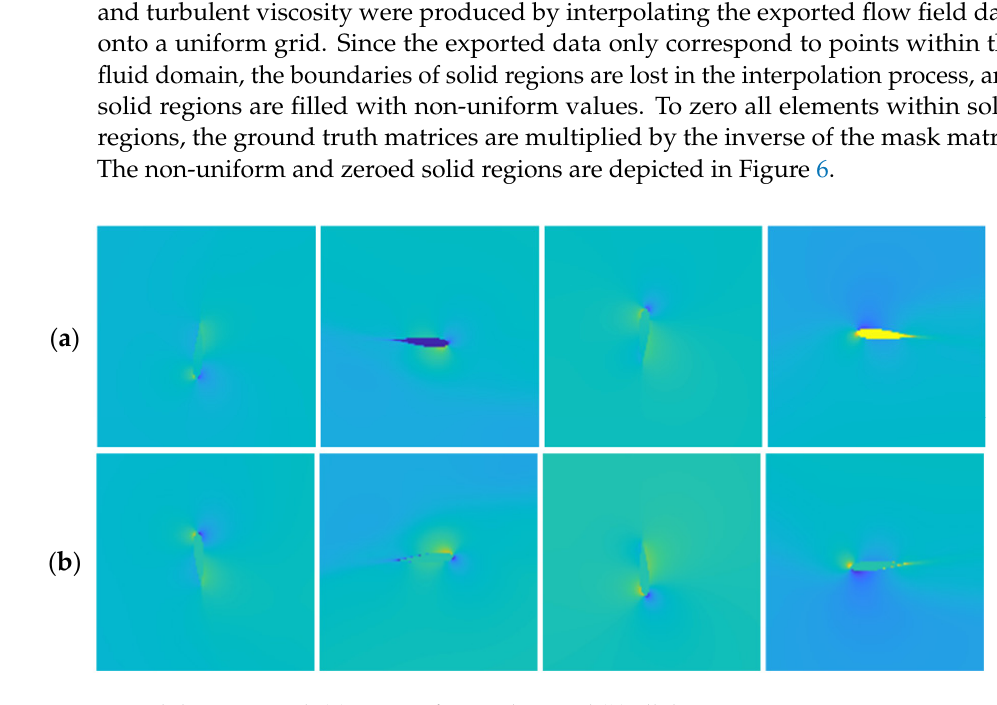
Figure 6. Solid regions with ( a ) non-uniform values and ( b ) all data points set to zero. 8.